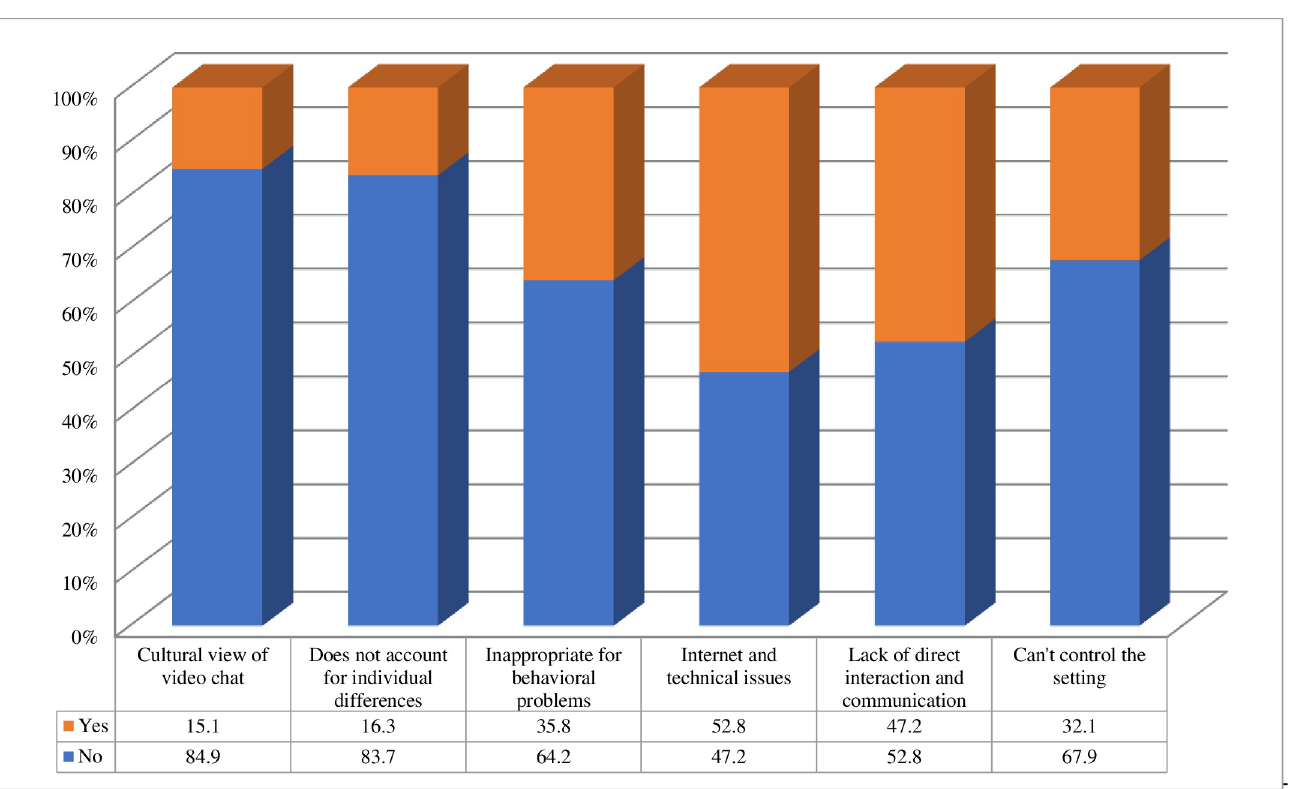
Fig 5. Barriers to telehealth practices (n =